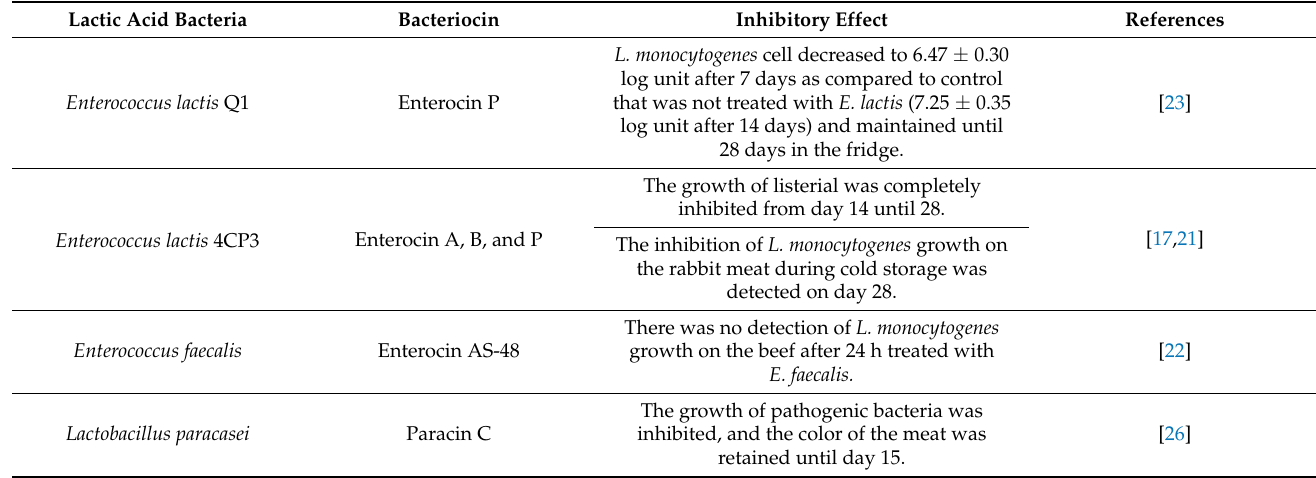
Table 2. Bacteriocin produced by lactic acid bacteria tested on raw